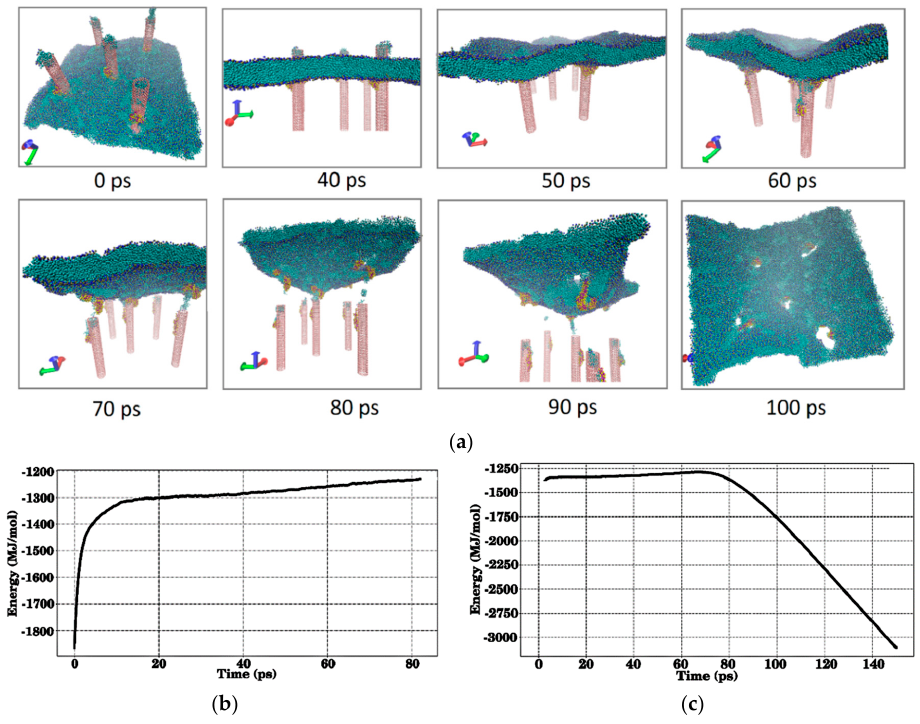
Figure 7. The interaction of the membrane with the SWCNT-collagen protein matrix: ( a ) Snapshots of the process of detachment of the membrane from the surface of the matrix; ( b ) a plot of change in the energy of the matrix + membrane system when the membrane falls on the matrix; ( c ) a plot of change in the energy of the matrix + membrane system when the membrane detaches from the matrix and moves away from it (SWCNTs are marked in pink, albumin molecules are marked in yellow and red, and the membrane is marked in green and